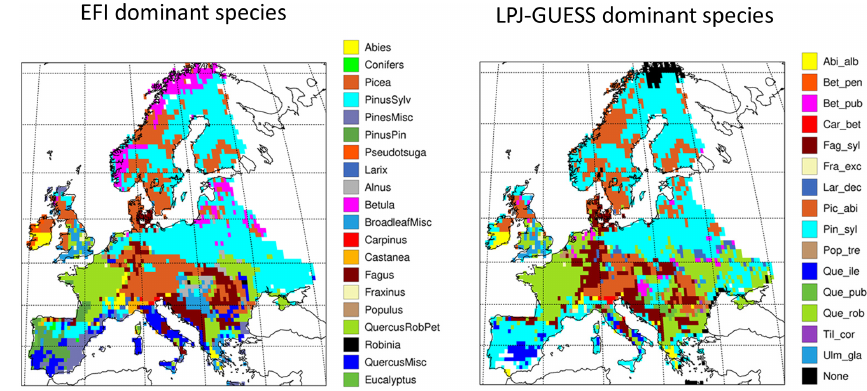
Figure C3. Comparison of dominant EFI tree species groups (area) and modelled LPJ-GUESS managed forest dominant tree species (LAI) in 1986–2015 in an LPJ-GUESS simulation with automated thinning. Abbreviations of LPJ-GUESS species are as in Fig. C2.